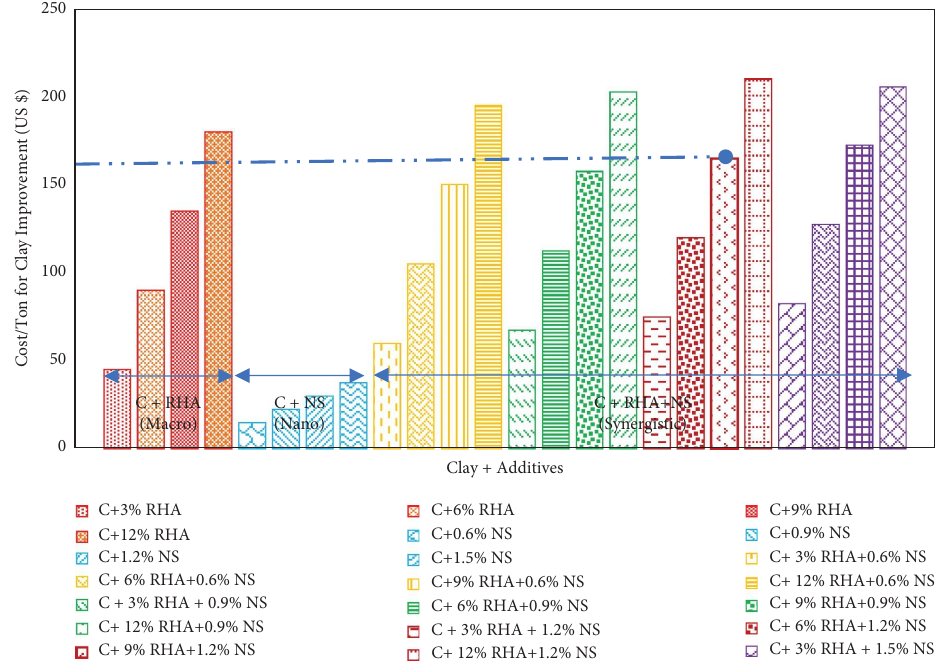
Figure 11: Cost versus stabilizer (RHA and NS)